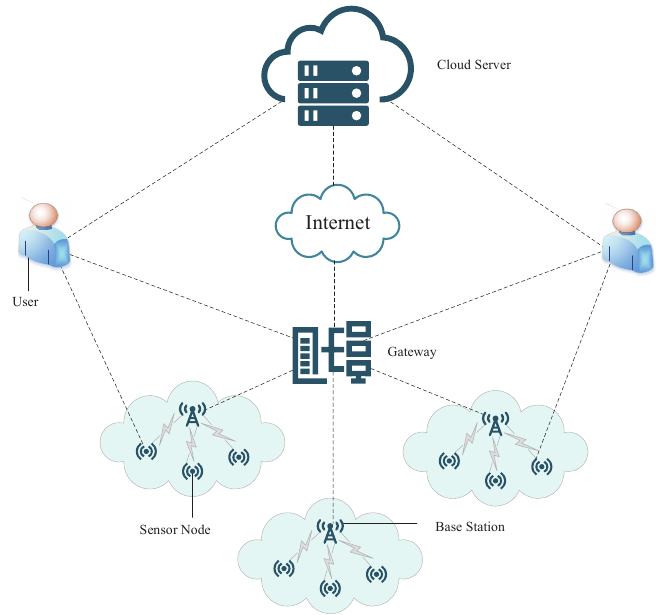
Figure 1. Cloud-assisted authentication model in